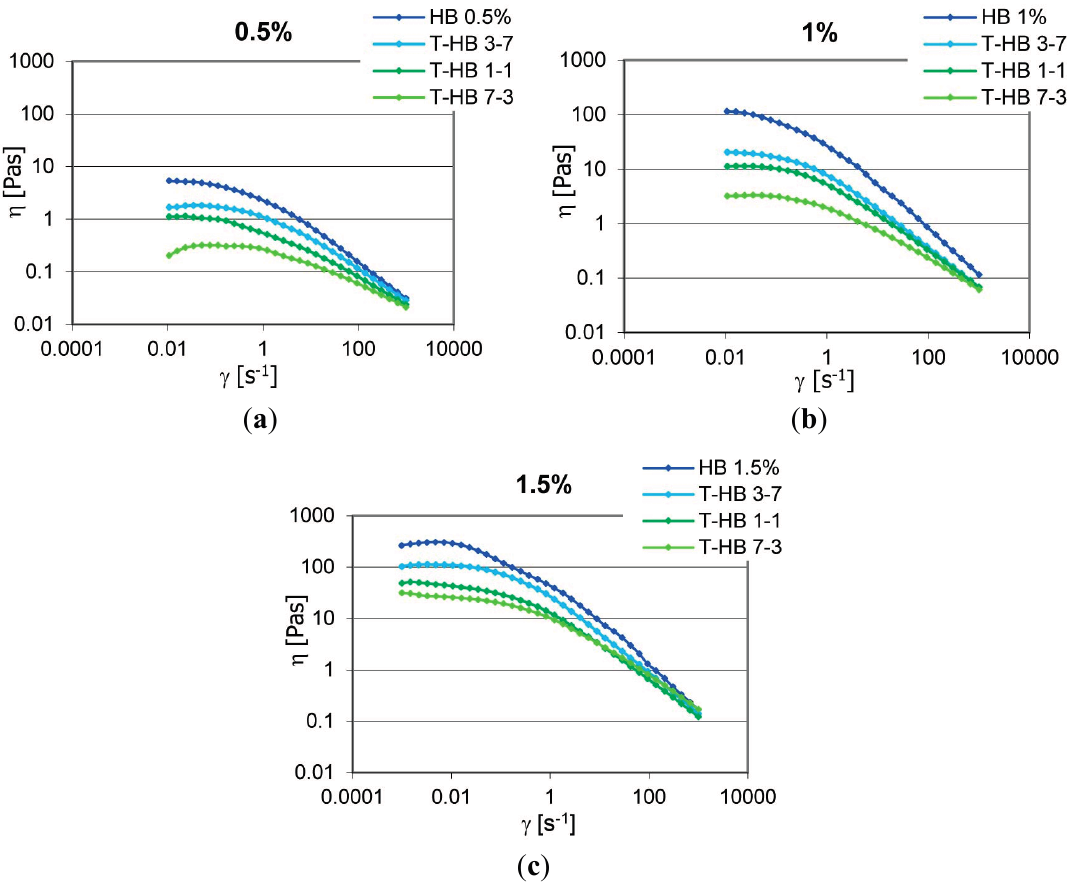
Figure 6. Viscosity trends vs. the shear rate of T-HB mixtures at different polymer concentrations: ( a ) 0.5%; ( b ) 1%; ( c ) 1.5%.